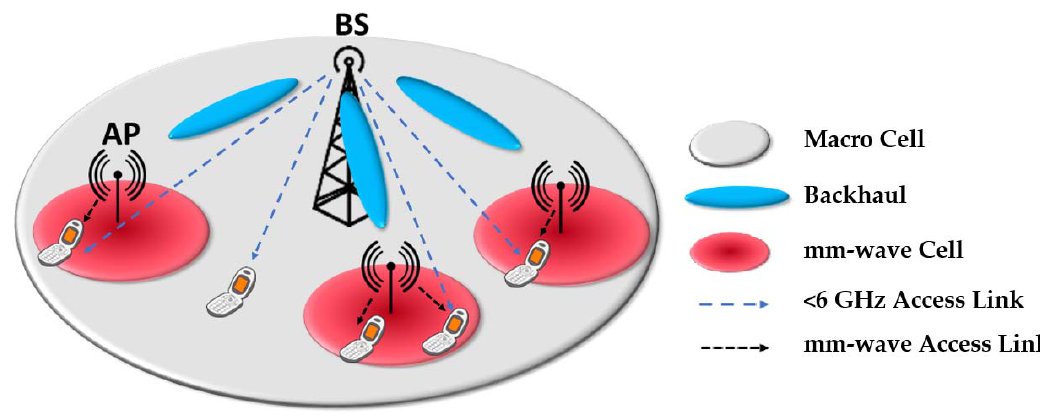
Figure 3. 5G heterogeneous mobile network scenario.